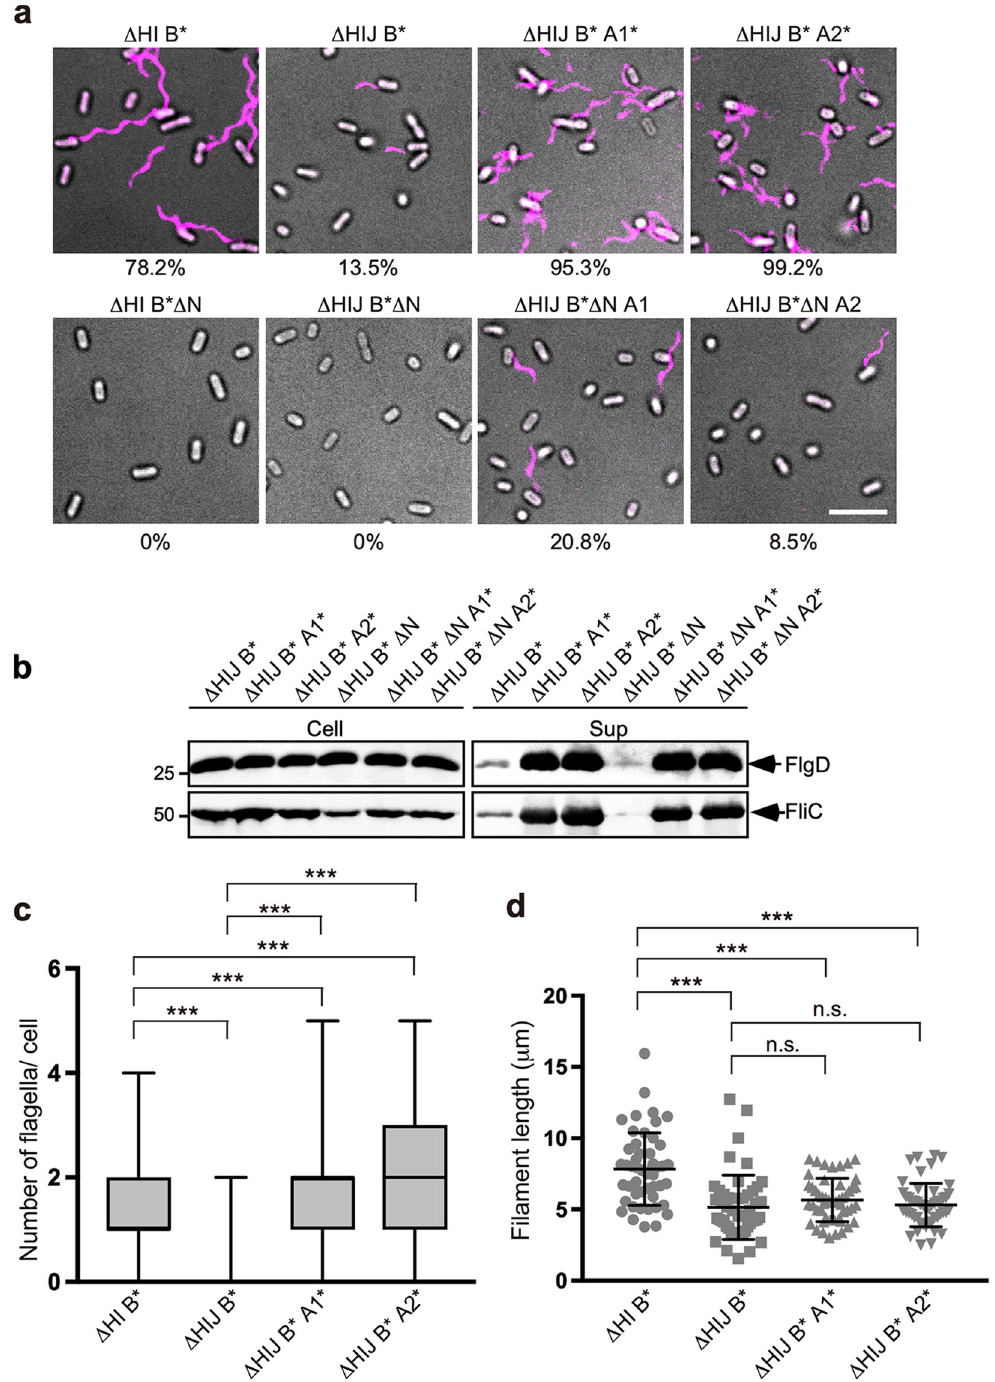
Fig. 4 Effects of gain-of-function mutations in FlhA and deletion of FlgN on fl agellar protein export and assembly by Δ HIJ B * cells. a Fluorescent images of MMHI0117 ( Δ HI B*), MMHIJ0117 ( Δ HIJ B * ), MMHIJ0117-2 ( Δ HIJ B * A1*), MMHIJ0117-3 ( Δ HIJ B * A2*), MM9002 ( Δ HI B* Δ N), MM9004 ( Δ HIJ B* Δ N), MM9004-2 ( Δ HIJ B* Δ N A1*), and MM9004-3 ( Δ HIJ B* Δ N A2*). The cells were grown in T-broth (pH 7.5) containing 100 mM NaCl until the cells reached the stationary phase. Flagellar fi laments were labelled with Alexa Fluor 594. The fl uorescence images of the fi laments labelled with Alexa Fluor 594 (magenta) were merged with the bright fi eld images of the cell bodies. Scale bar, 5.0 μ m. b Immunoblotting, using polyclonal anti-FlgD (1st row) or anti-FliC (2nd row) antibody, of whole-cell proteins (Cell) and culture supernatant fractions (Sup) prepared from the MMHI0117, MMHIJ0117, MMHIJ0117-2, and MMHIJ0117-3 cells. The regions of interest were cropped from original immunoblots shown in Supplementary Fig. 12. c , d Average number and length of fl agellar fi laments in the MMHI0117, MMHIJ0117, MMHIJ0117-2, and MMHIJ0117-3 cells. Filament length is the average of 50 fi laments, and vertical lines are standard deviations. Comparisons between datasets were performed using a two-tailed Student ’ s t -test. A P -value of <0.05 was considered to be statistically signi fi cant difference. *** P < 0.001; n.s. no statistical signi fi cance. (See Supplementary Table 2).